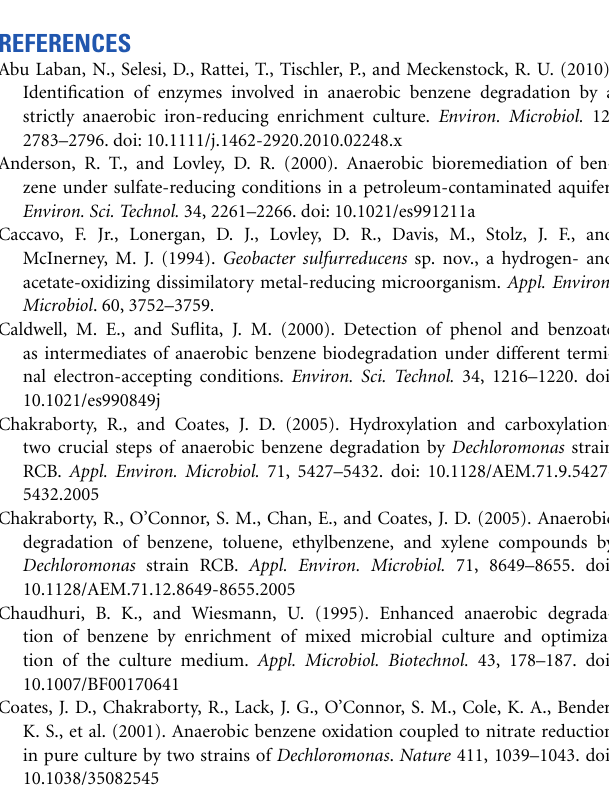
Table S1 | Bacterial strains and plasmids used in this